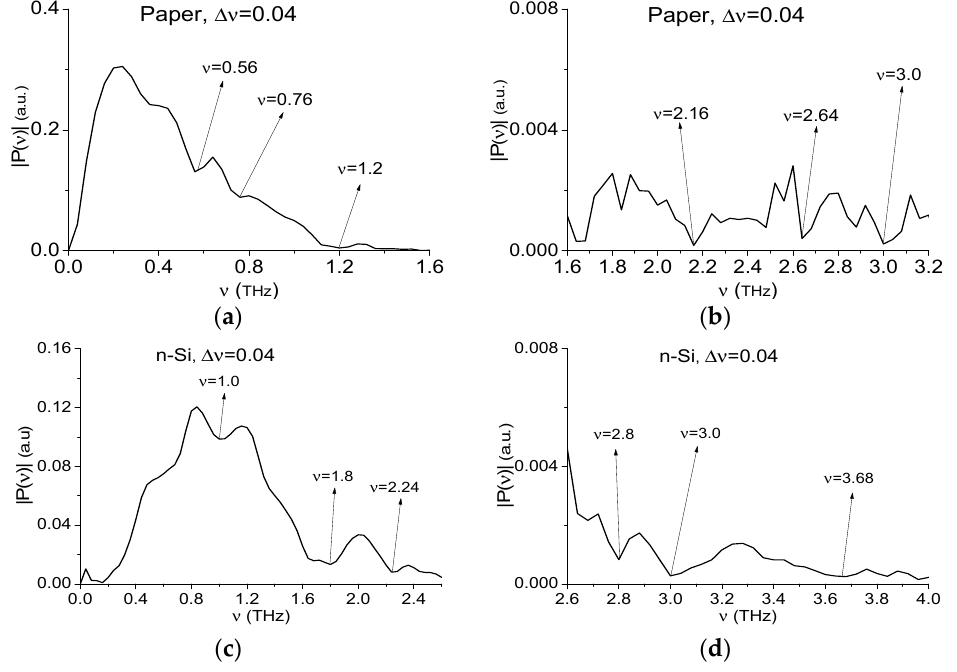
Figure 3. Spectra of the THz signals, transmitted through the paper ( a,b ) or n-Si ( c,d ), depicted in the frequency ranges ν = [0, 1.6] THz ( a ), [1.6, 3.2] THz (b), ν = [0, 2.6] THz ( c ) and [2.6, 4.0] THz ( d ). The corresponding spectral resolution Δ ν = 0.04 THz.